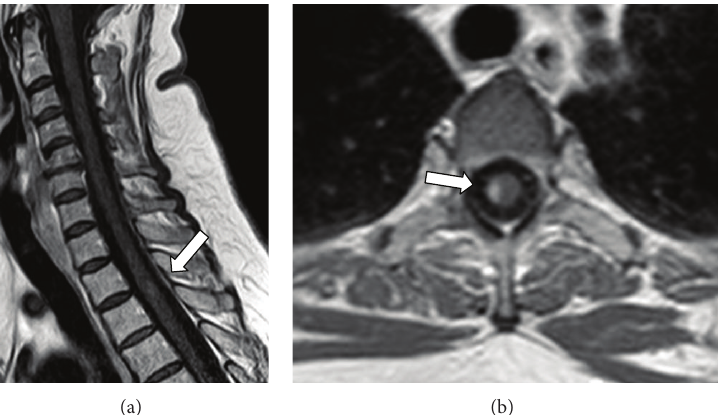
Figure 4: (a) Sagittal and (b) axial T1-weighted cervical/thoracic MRI showing contrast enhanced lesion at the T2-T3 level.